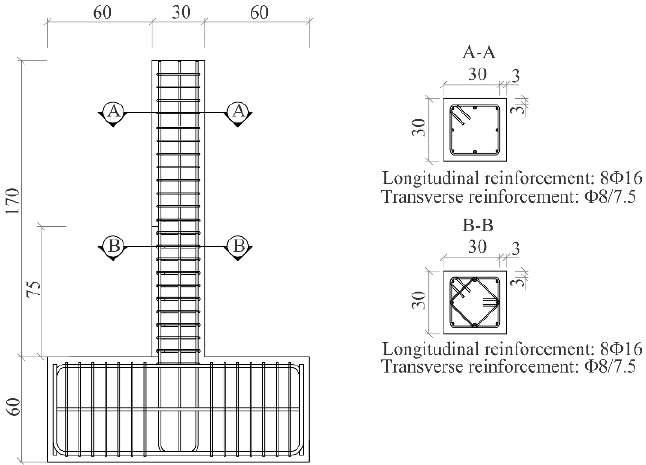
Figure 4. Elevation view of specimen with reinforcement, and cross-sections of column of specimen reinforced with B500B.